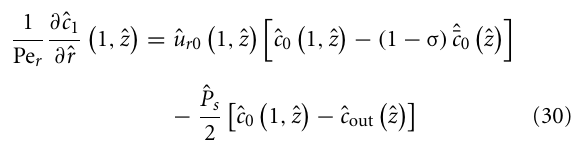
( Figure 2D ). If the permeability of the membrane, P s ,